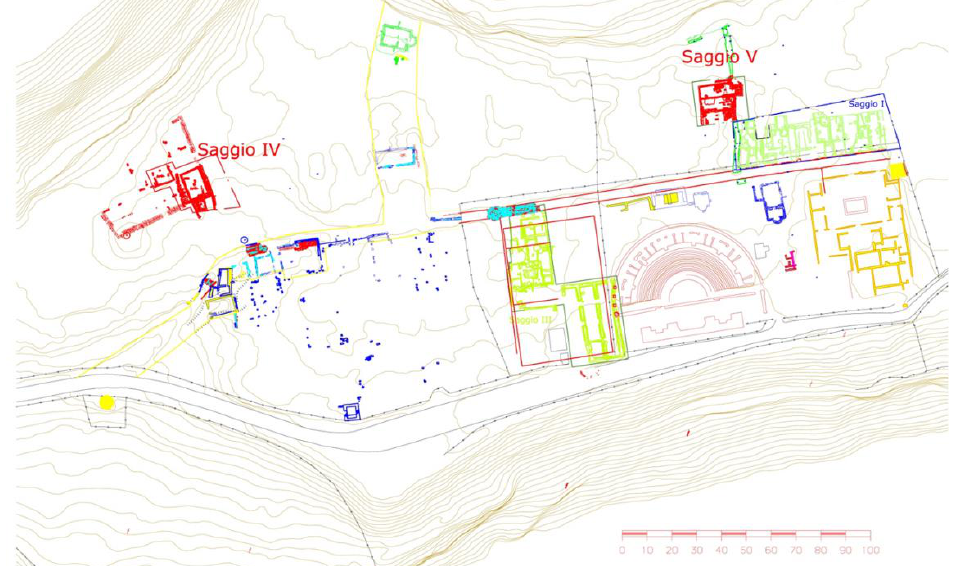
Figure 2. Planimetry of the excavation areas with the test pits (named IV and V) from which the examined objects were recovered.